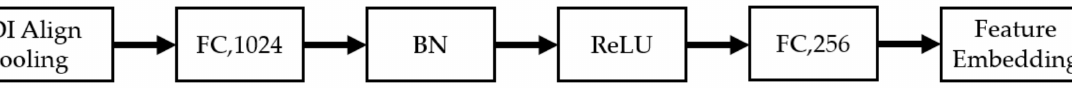
Figure 5. Structure of DML encoding module.